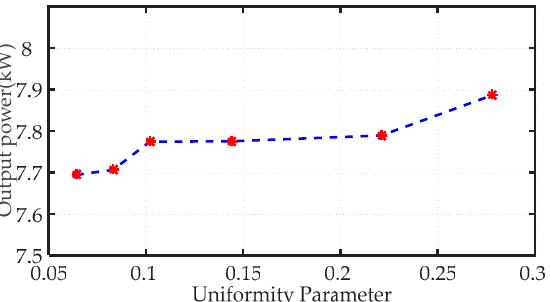
Figure 7. The changing of the output power with uniformity parameter, and the output power is affected slightly.